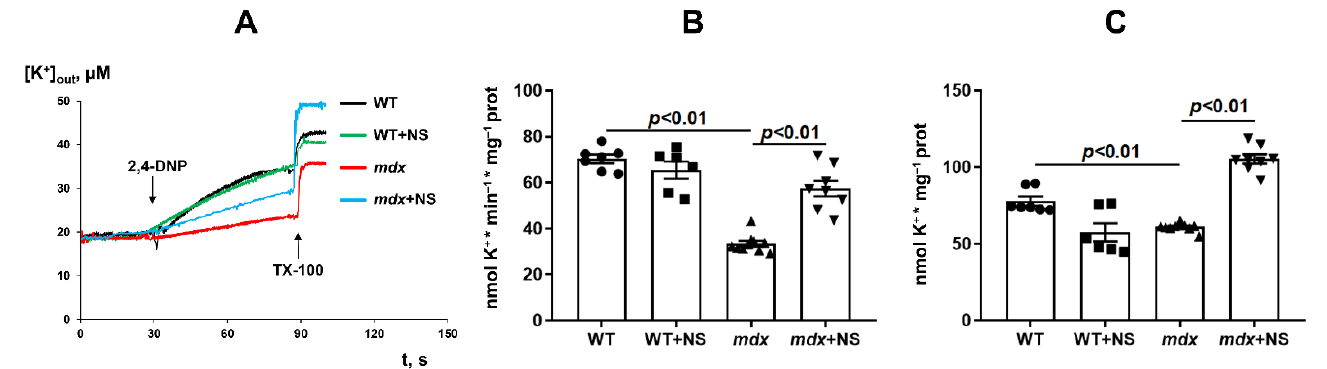
Respiration of mitochondria in state 3 was initiated by 200 µ M of ADP. Mitochondrial respiration in the 3U DNP state was induced by 50 µ M of DNP. The data are presented as m ± SEM. * p < 0.05 versus WT group. # p < 0.05 versus mdx group.